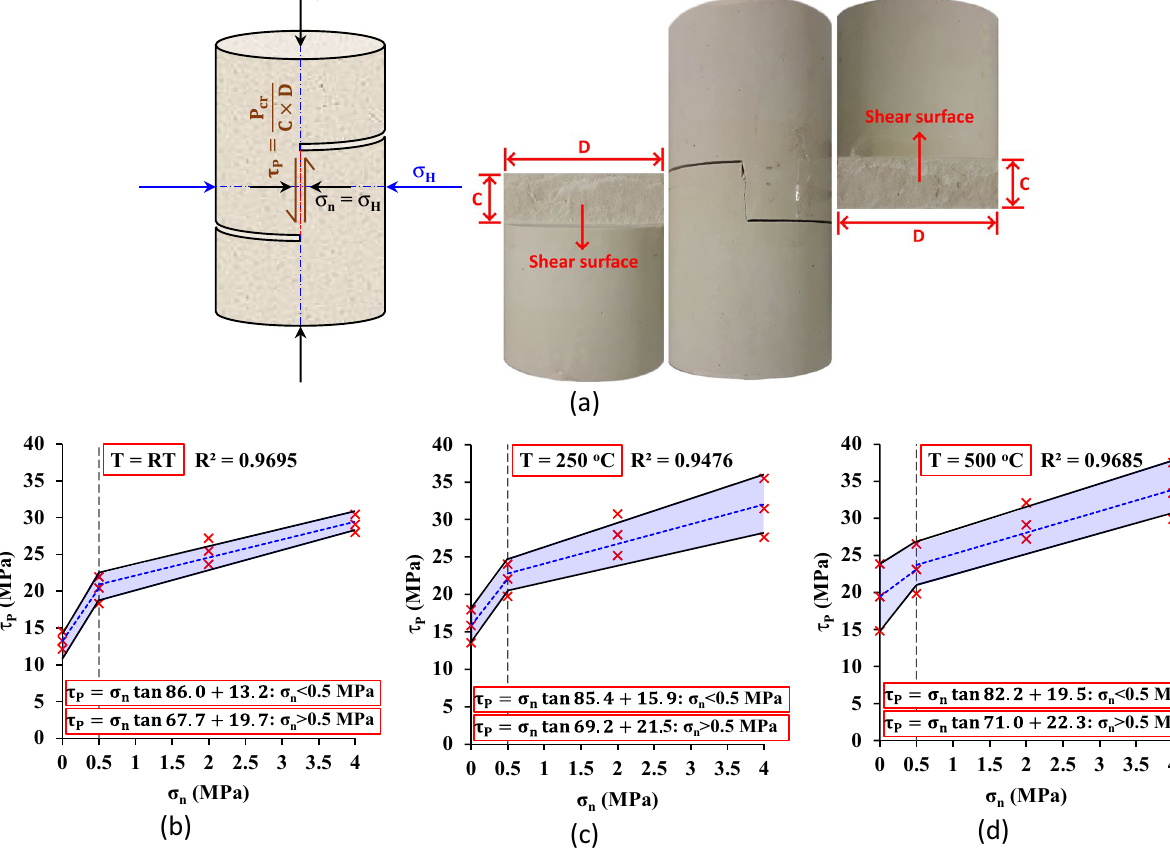
Figure 10. ( a ) Schematic diagram of the SCC sample containing rock bridge with a tested sample of mudstone showing shear surfaces, ( b – d ) peak shear strength/normal stress behavior of intact mudstone under RT, 250 and 500 °C,